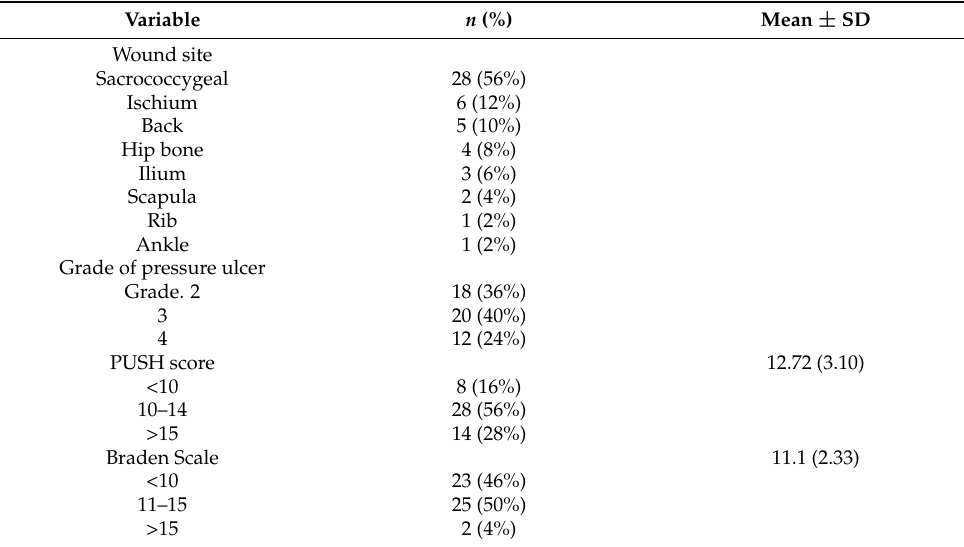
Table 2. Pressure-wound characteristics ( n = 50).